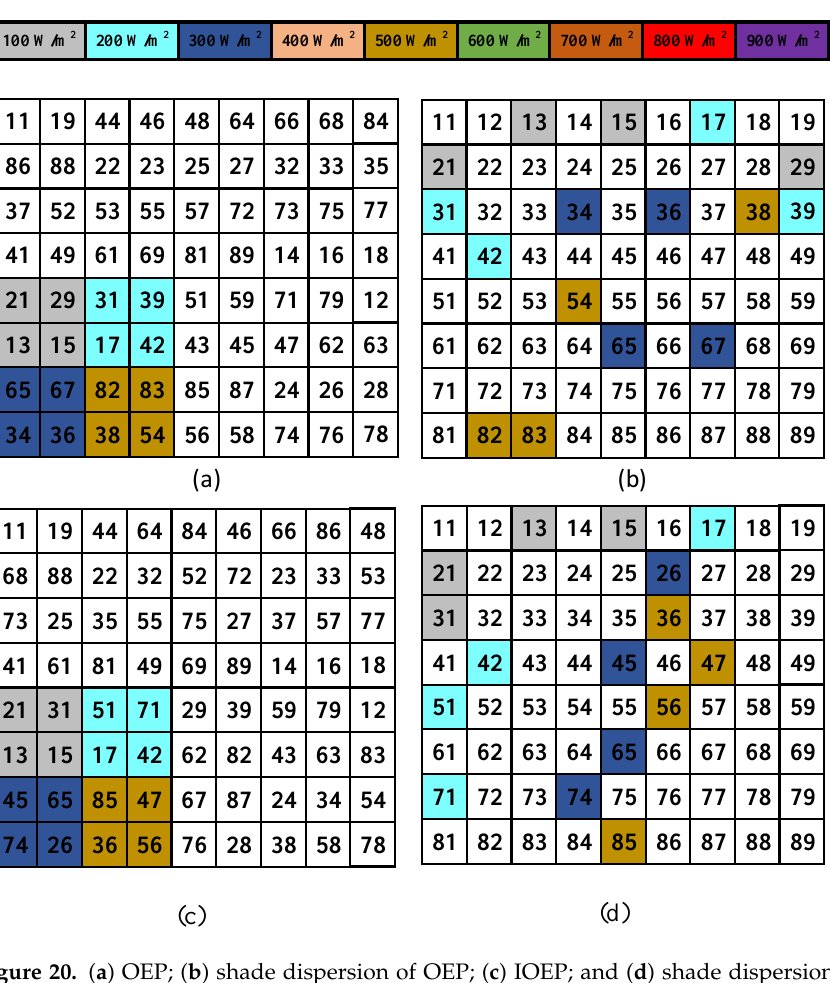
In Case-IV, in the Bottom-Right corner, 16 PV modules are partially shaded, as seen in the Figure